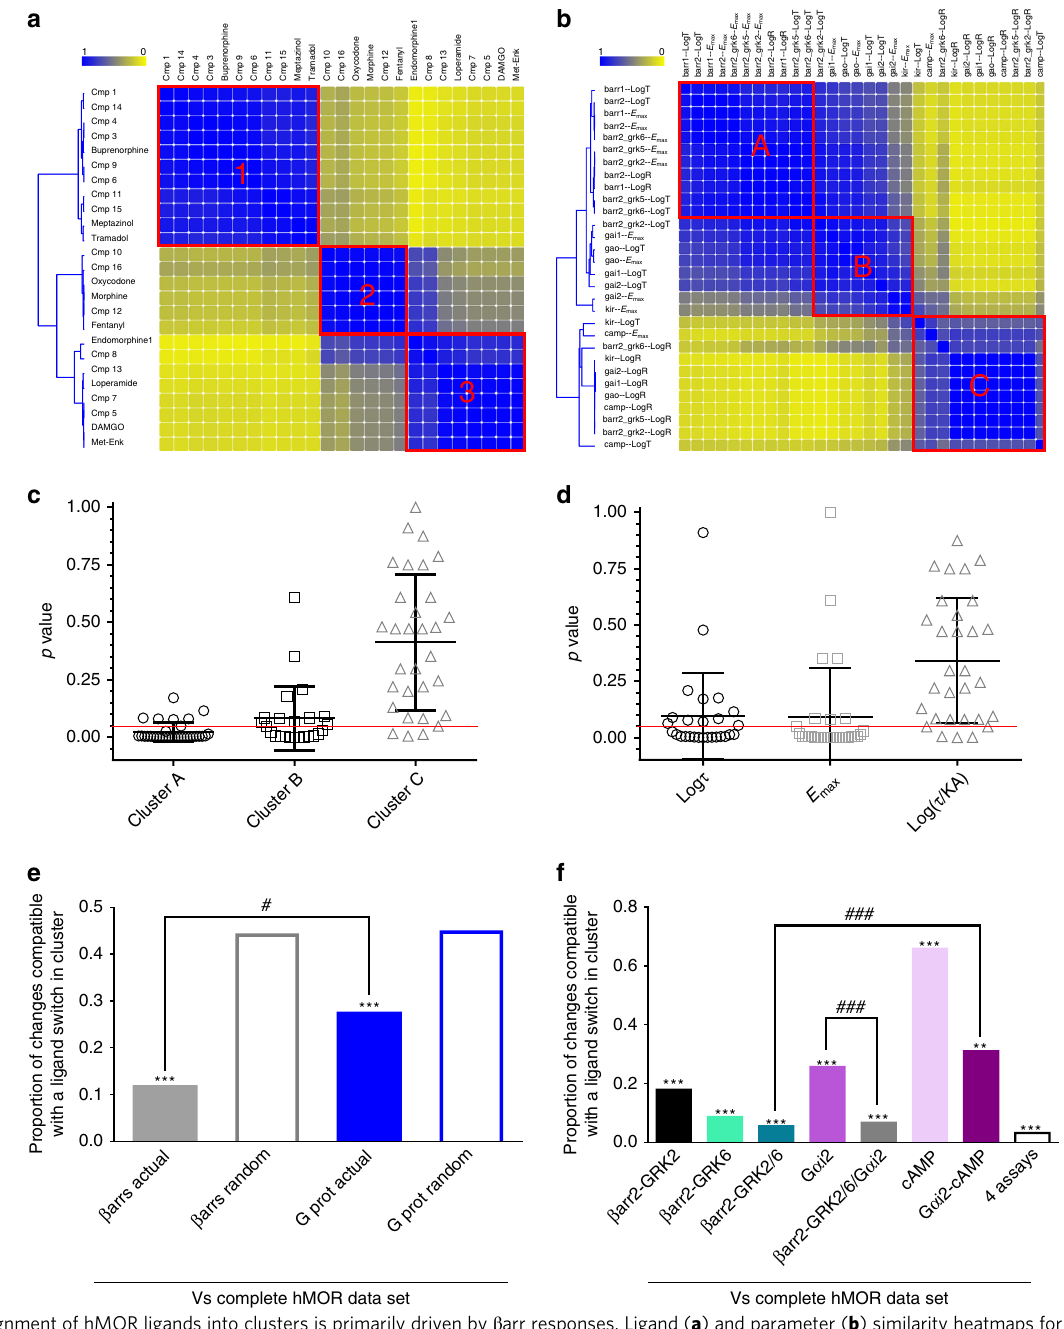
Fig. 3 Assignment of hMOR ligands into clusters is primarily driven by β arr responses. Ligand ( a ) and parameter ( b ) similarity heatmaps for the complete hMOR data set. Yellow and blue, respectively indicate ligands/parameters that never or always cluster together. Distribution of parameters describing ligands within clusters shown in ( a ) was compared to their distribution in the whole population using a two-sample Kolmogorov – Smirnov test. Resulting p- values were plotted according to clusters shown in ( b ) ( c ) or to parameter type ( d ), mean ± SD are also shown. Red line: p = 0.05. Similarity matrices corresponding to partial data sets for β arr- or G-protein-mediated responses were compared with the complete, reference hMOR data set. Filled bars: proportion of ligands changing clusters when comparing actual β arr and G-protein data sets to the reference; empty bars: proportions observed by comparing simulations of random clustering to the reference data set. *** p < 0.001; -z score β arr: − 5.375; z -score G protein: − 6.092. # p < 0.05; z- score difference: − 2.22 ( e ). Similarity matrices generated for indicated partial responses were compared with the hMOR reference matrix. The results for actual data matrices are shown while results for random simulations were omitted. ** p < 0.01; *** p < 0.001 comparing partial data sets to their randomized controls; z- scores for comparisons between actual and randomized data: β arr2-GRK2: − 12.724; β arr2-GRK6: − 10.583; β arr2-GRK2/GRK6: − 8.835; G α i2: − 7.315; cAMP: 6.297; G α i2- cAMP: − 2.351; four assays − 8.541; β arr2-GKR2/6/G α i2: − 7.391. ### p < 0.001; z -score difference: β arr2-GRK2/6 vs. G α i2/ cAMP: − 3.308; z- score difference: G α i2 vs β arr2-GRK2/6-G α i2: 3.754 ( f ). Source data provided in Supplementary Data 1 and as a source data fi